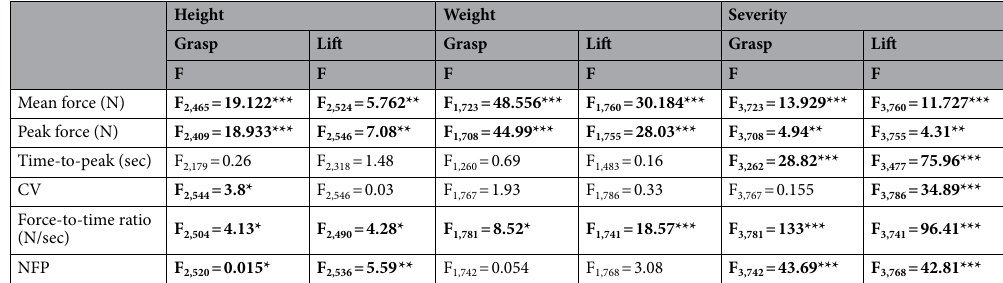
Table 2. Mean values of force variables: effect of height, weight, and severity. Summary of the forces results. Bolded values denote a significant difference between the groups. Height, Weight, Severity: list the F value for the differences across this parameter; Asterisks denote the p value: * p < 0.05, ** p < 0.01, *** p < 0.001. N Newtons, sec Seconds, CV Coefficient of variance, NFP Number of force peaks.